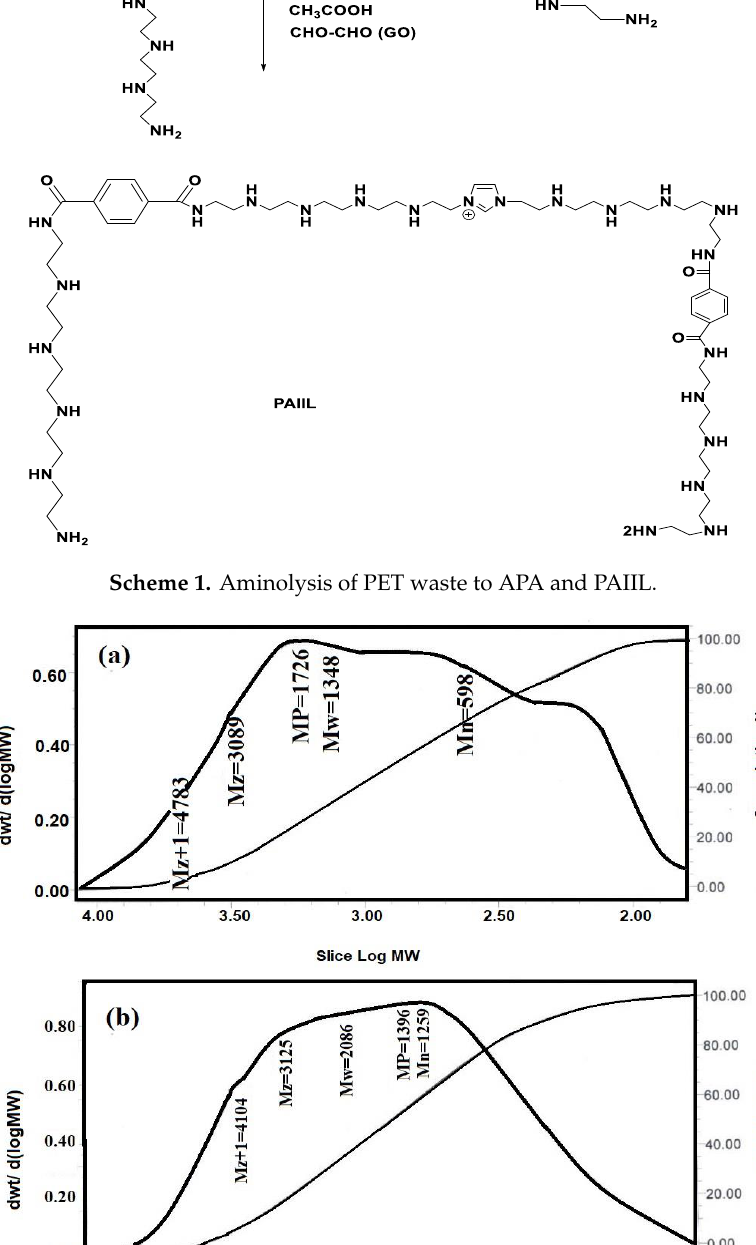
Figure 1. GPC data of ( a ) APA and ( b ) PAIIL.